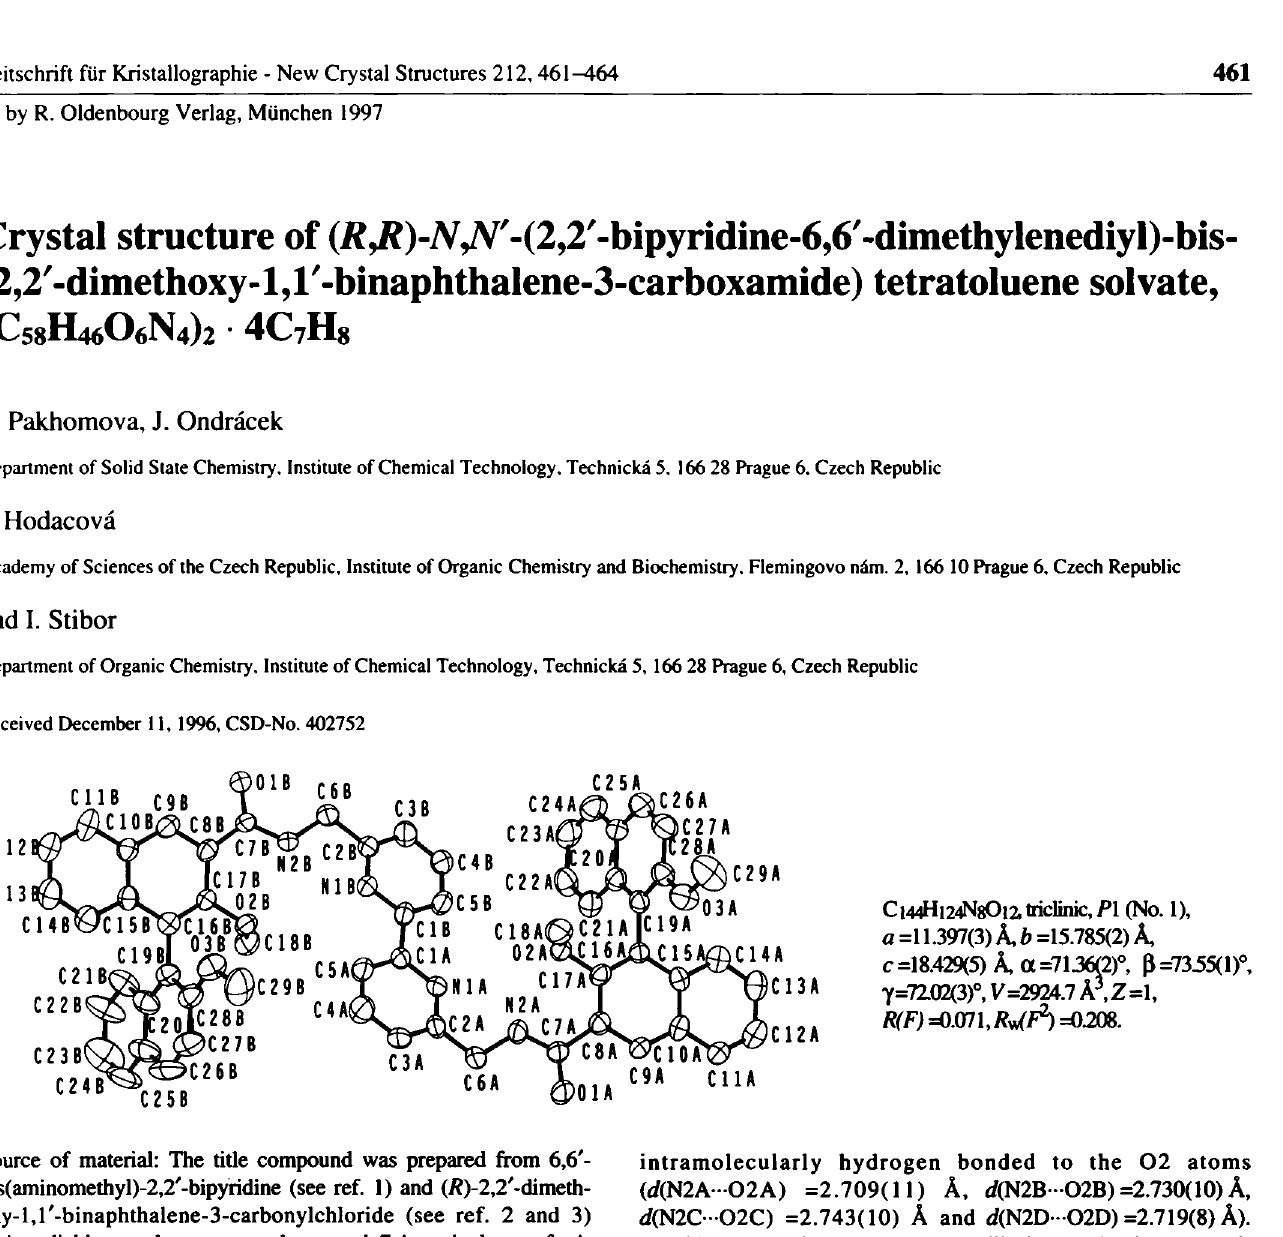
Table 2. Final atomic coordinates and displacement parameters (in A 2